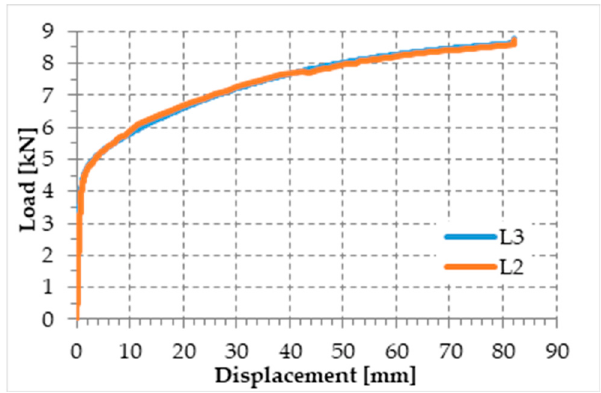
Figure 22. Load/displacement diagrams for the steel ribbons used in [1]. Figure 22. Load / displacement diagrams for the steel ribbons used in